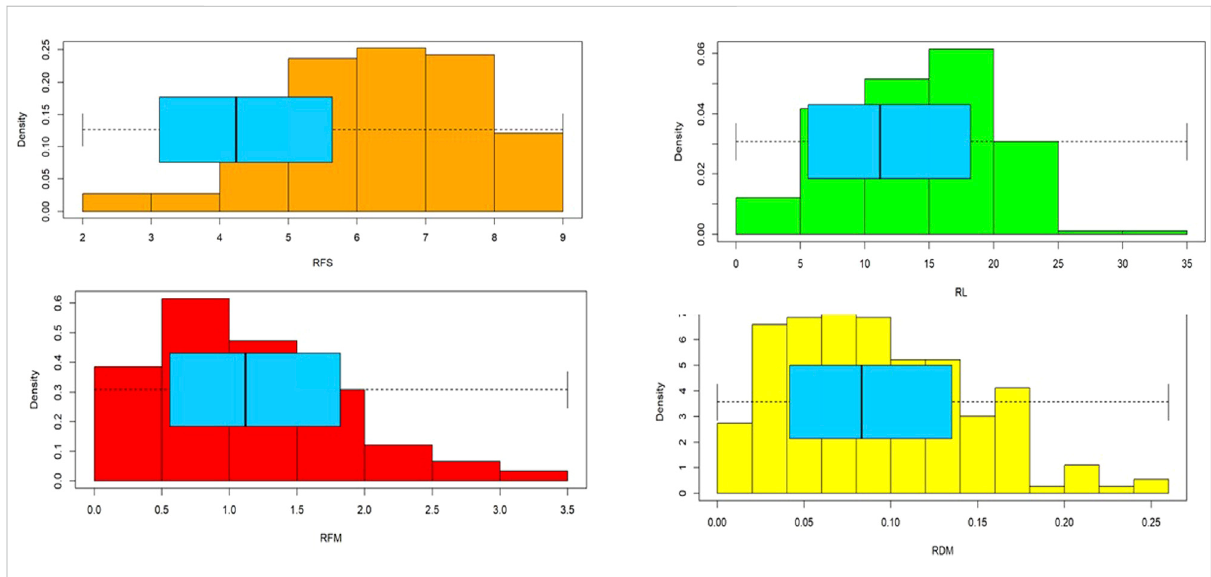
FIGURE 2 Histogram showing thedistributionofall genotypes ineachtrait and box plot analysis illustrating theminimum, maximum, andmean values for each